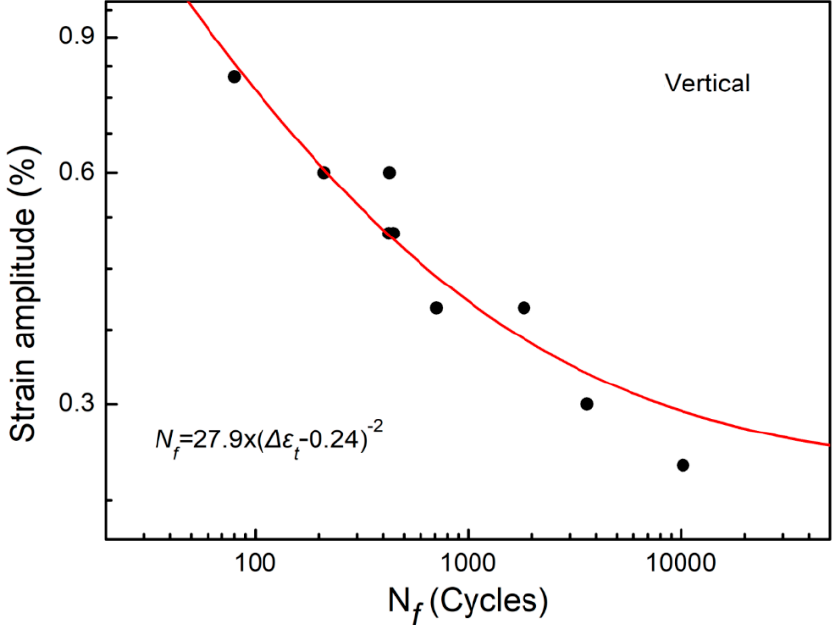
Figure 6. Tensile curves of SAAM workpieces along different directions.